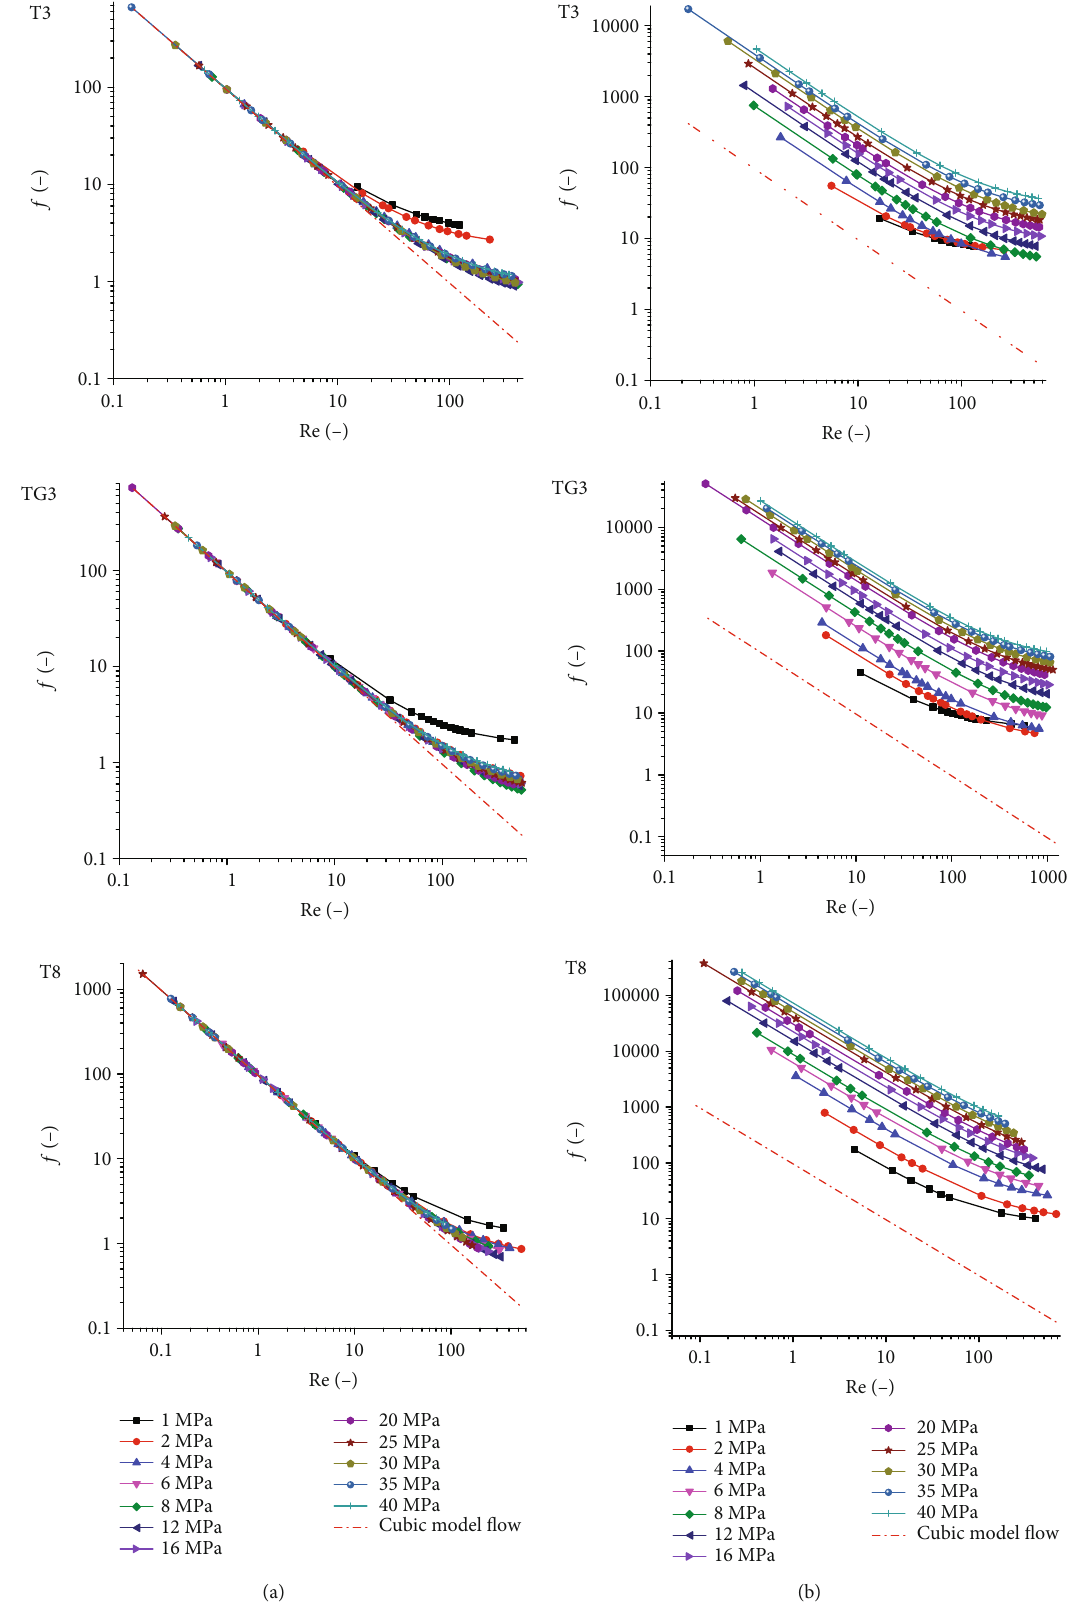
Figure 10: Friction factor as a function of the Reynolds number for the (a) parallel-plate fl ow model and the (b) model proposed in this